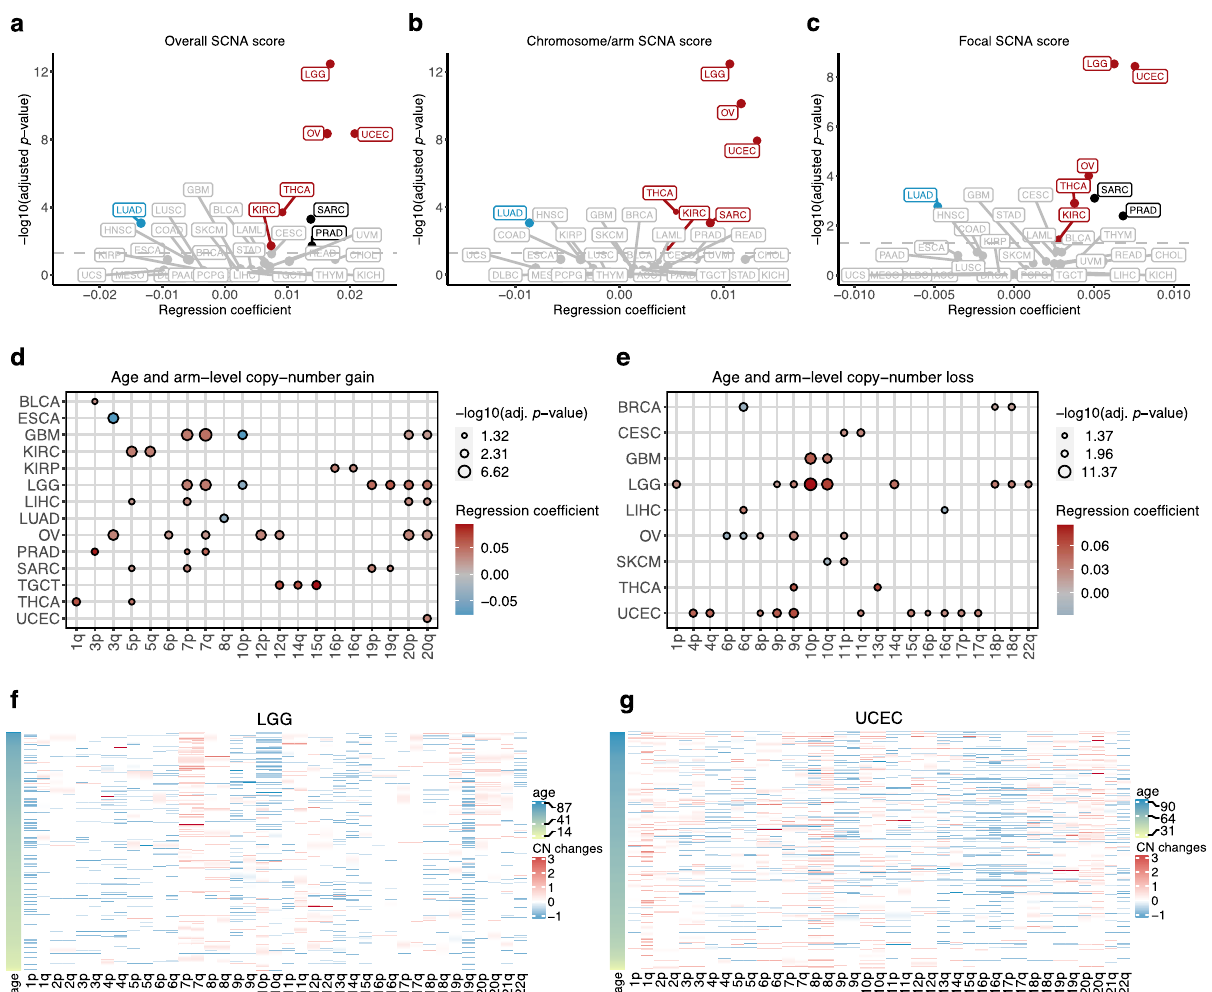
Fig. 2 Association between cancer patients ’ age and somatic copy-number alterations (SCNAs). Volcano plot representing the association between age and ( a ) overall, ( b ) focal-level and ( c ) chromosome/arm-level SCNA scores. Linear regression coef fi cients and signi fi cant values are shown. Multiple- hypothesis testing correction was done using Benjamini – Hochberg procedure. Cancers with a signi fi cant positive and negative association between age and SCNA score after using multiple linear regression (adj. p value < 0.05) are highlighted in red and blue, respectively. Cancers with a signi fi cant association in simple linear regression but not signi fi cant after using multiple linear regression are showed in black. The grey line indicates adj. p value = 0.05. Dot size is proportional to median SCNA score. d , e The left and right dot plots show the association between age and arm-level copy-number gains and copy-number losses. Multiple logistic regression coef fi cients and signi fi cant values are shown. Multiple-hypothesis testing correction was done using Benjamini – Hochberg procedure. Circle size corresponds to the signi fi cant level, red and blue represent positive and negative associations, respectively. f , g Heatmaps represent arm-level copy-number alterations in LGG and UCEC, respectively. Samples are sorted by age. Colours represent copy-number changes from GISTIC2.0, blue denotes loss and red corresponds to gain. TCGA cancer type acronyms and their associated name are provided in Table